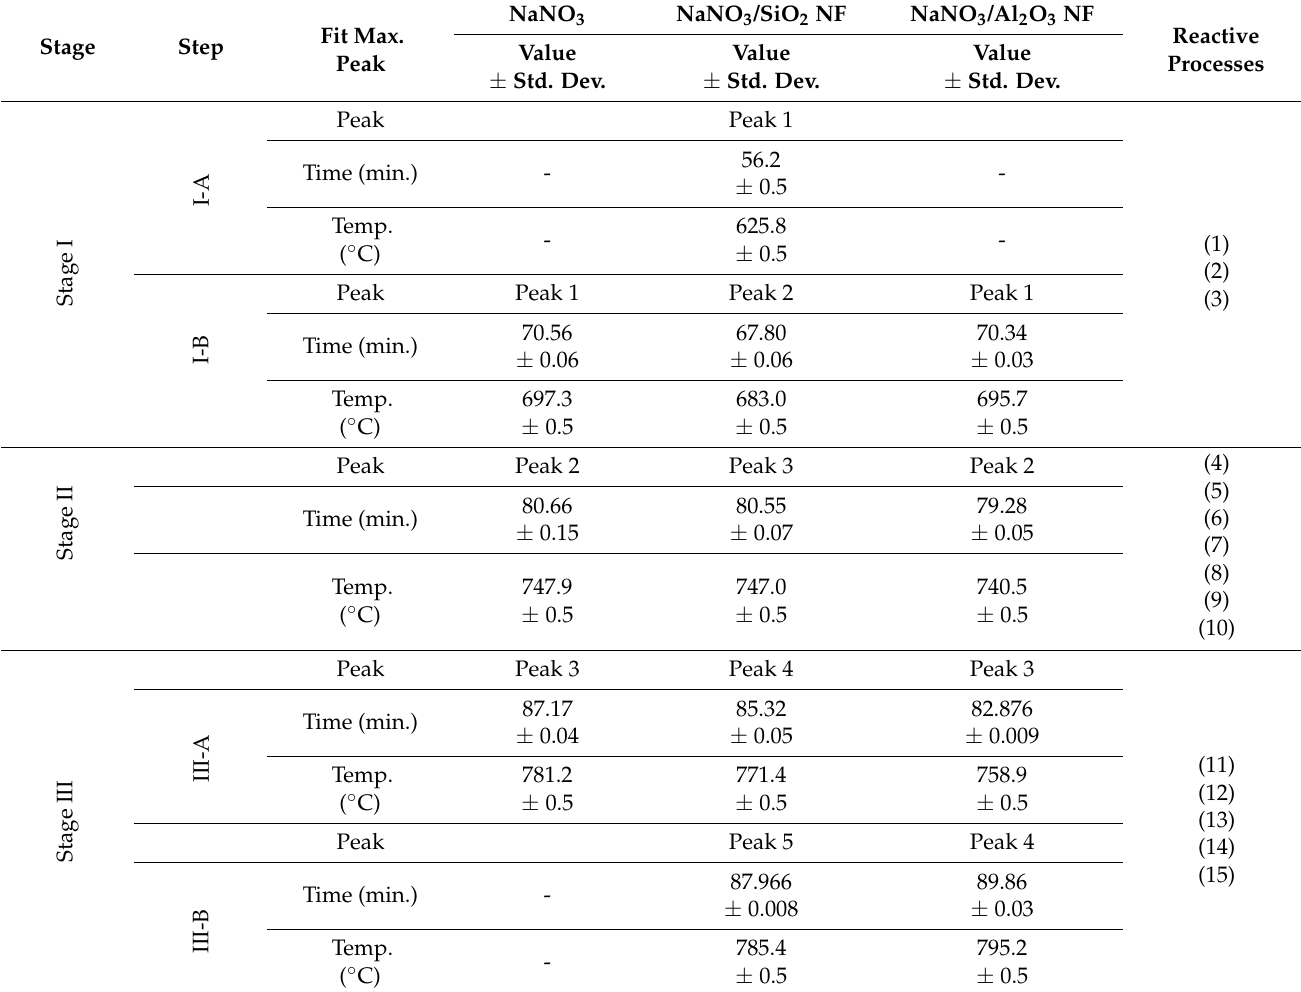
Table 4. Gaussian non-linear fit parameters and the predominant reactions involved of the deconvo- luted peaks for NaNO 3 , NaNO 3 /SiO 2 NF (1% wt.) and NaNO 3 /Al 2 O 3 NF (1% wt.). NaNO 3 NaNO 3 /SiO 2 NF NaNO 3 /Al 2 O 3 NF Fit Max. Peak